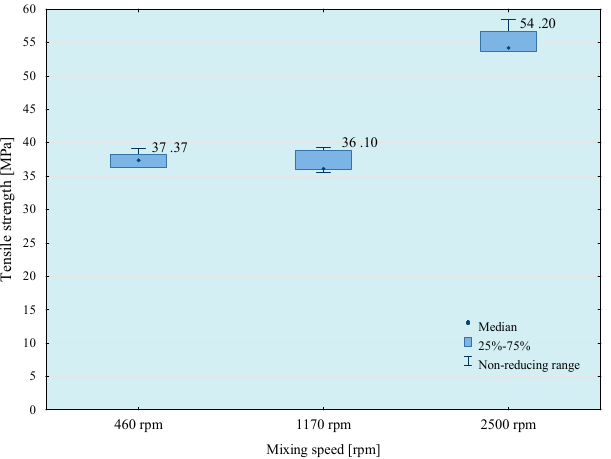
Figure 7. Tensile strength of E57/Z-1/100:10 composition as a function of mixing speed.